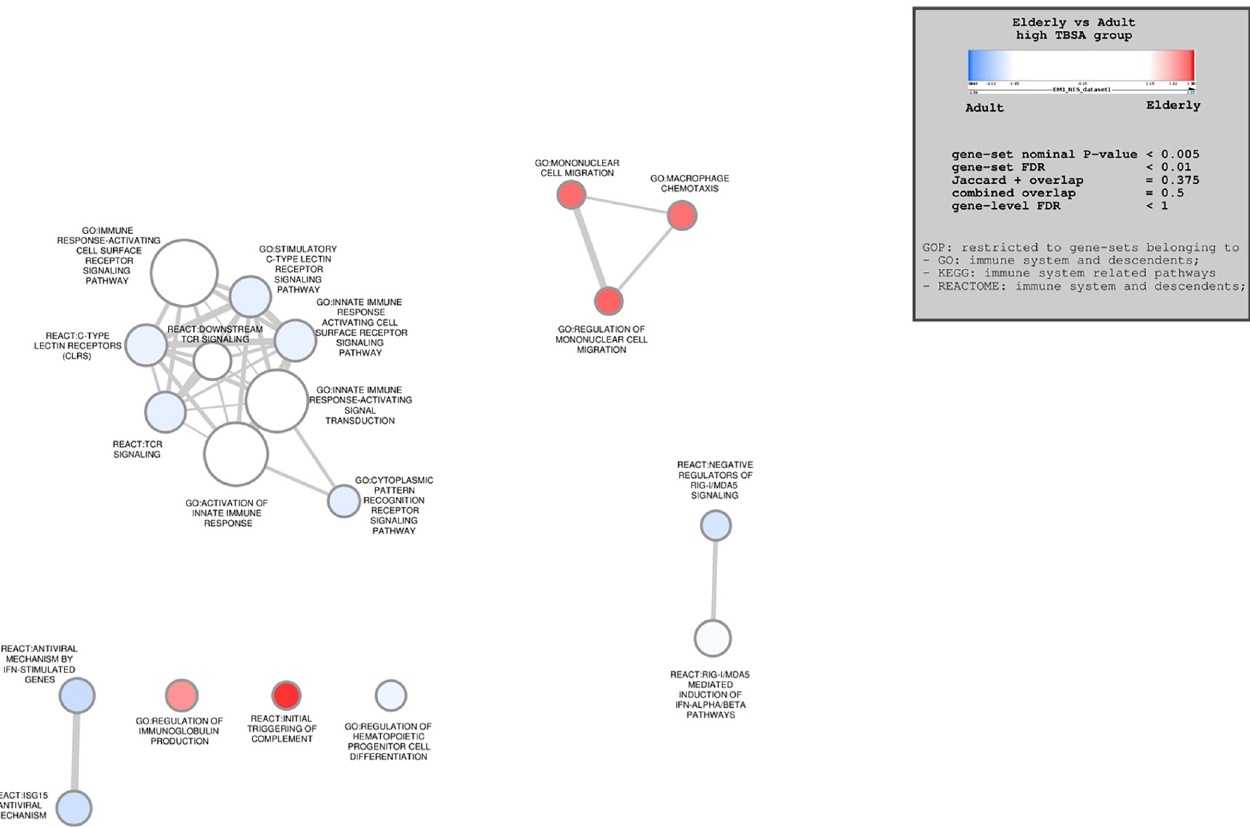
Fig 2. Enrichment map outlining significantly altered immune-related pathways for comparison group 2 (high TBSA). Blue nodes represent pathways downregulated in the elderly group, red nodes represent pathways upregulated in the elderly group. Node size is proportional to gene set size.